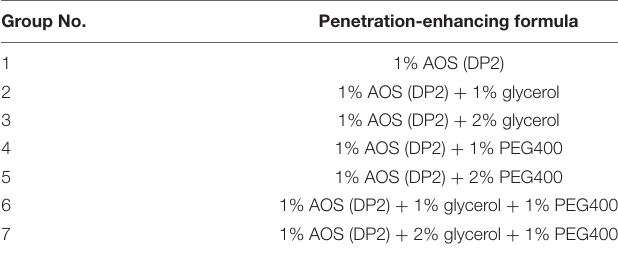
TABLE 2 | Experimental design of algal oligosaccharide (AOS) transdermal permeation-enhancing formula. Group